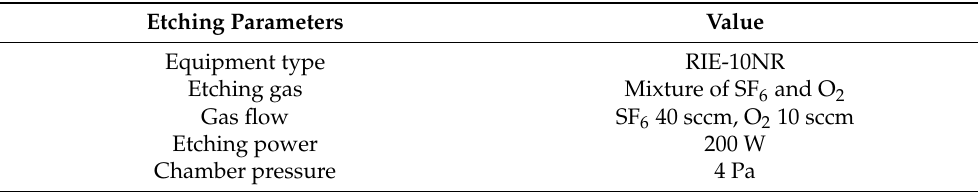
Table 1. Reactive ion etching machine (RIE) etching parameters of SiC.